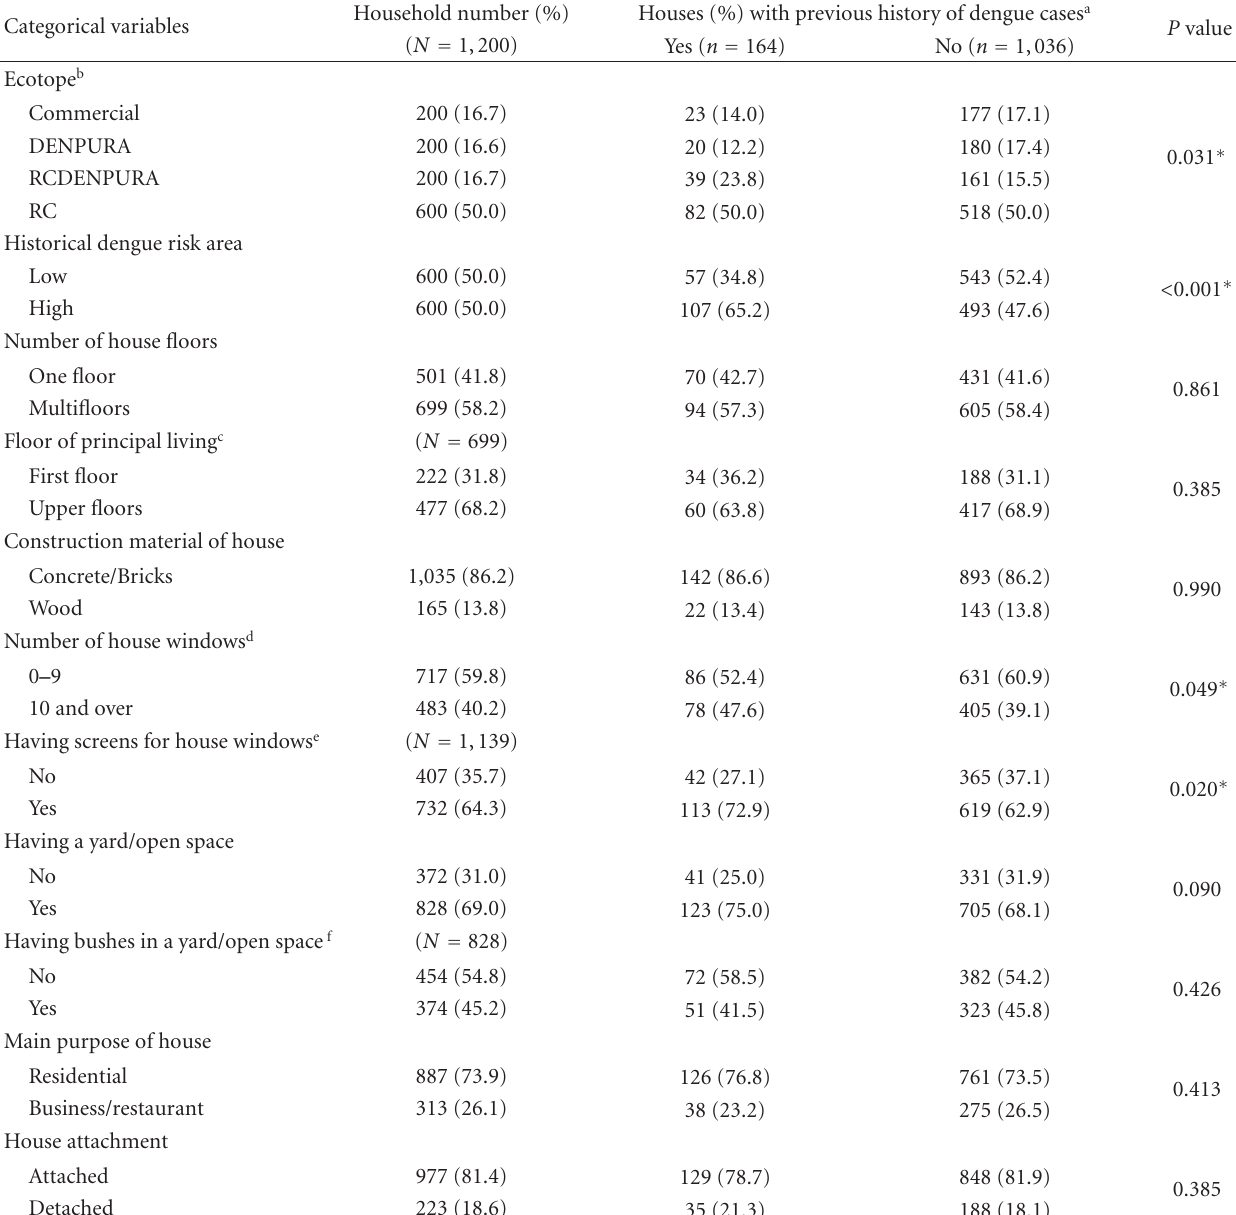
Table 1: Univariate analysis of the association between ecological factors of households and dengue transmission. Categorical